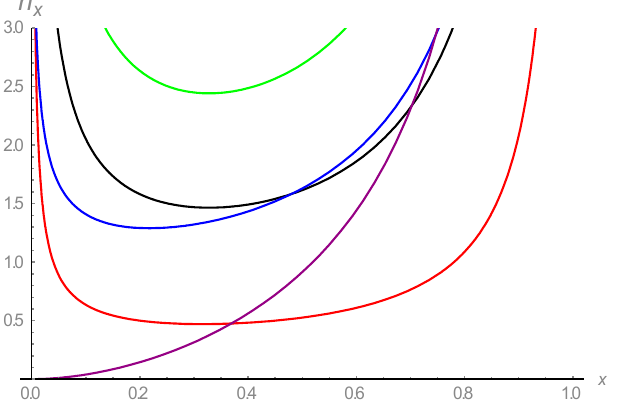
Figure 2. Plots of 3PB HRF: α = 0.2, β = 0.1, δ = 2 (red), α = 0.6, β = 0.2, δ = 1 (black), α = 0.7, β = 0.9, δ = 1 (blue), α = 1, β = 2.2, δ = 1.3 (purple), α = 1, β = 0.2, δ = 1